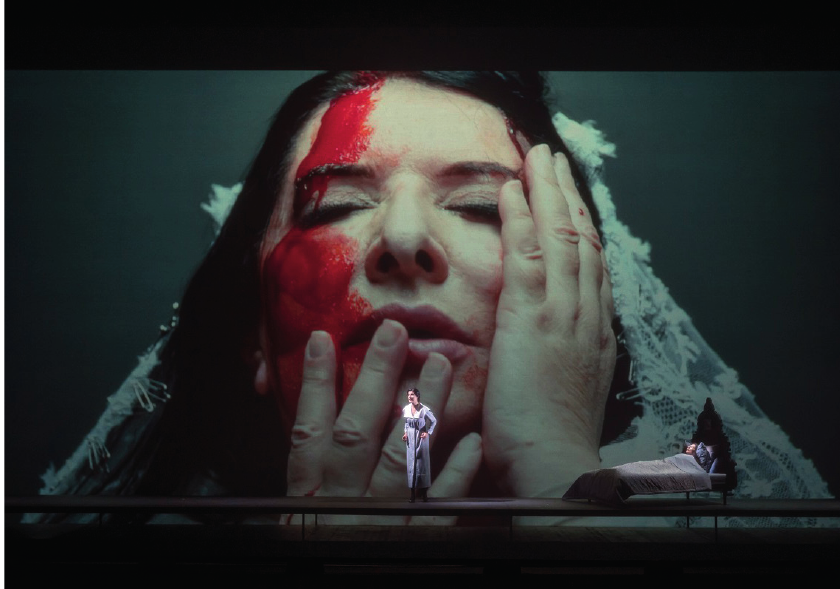
Fig. 4 7 Deaths of Maria Callas (© Charles